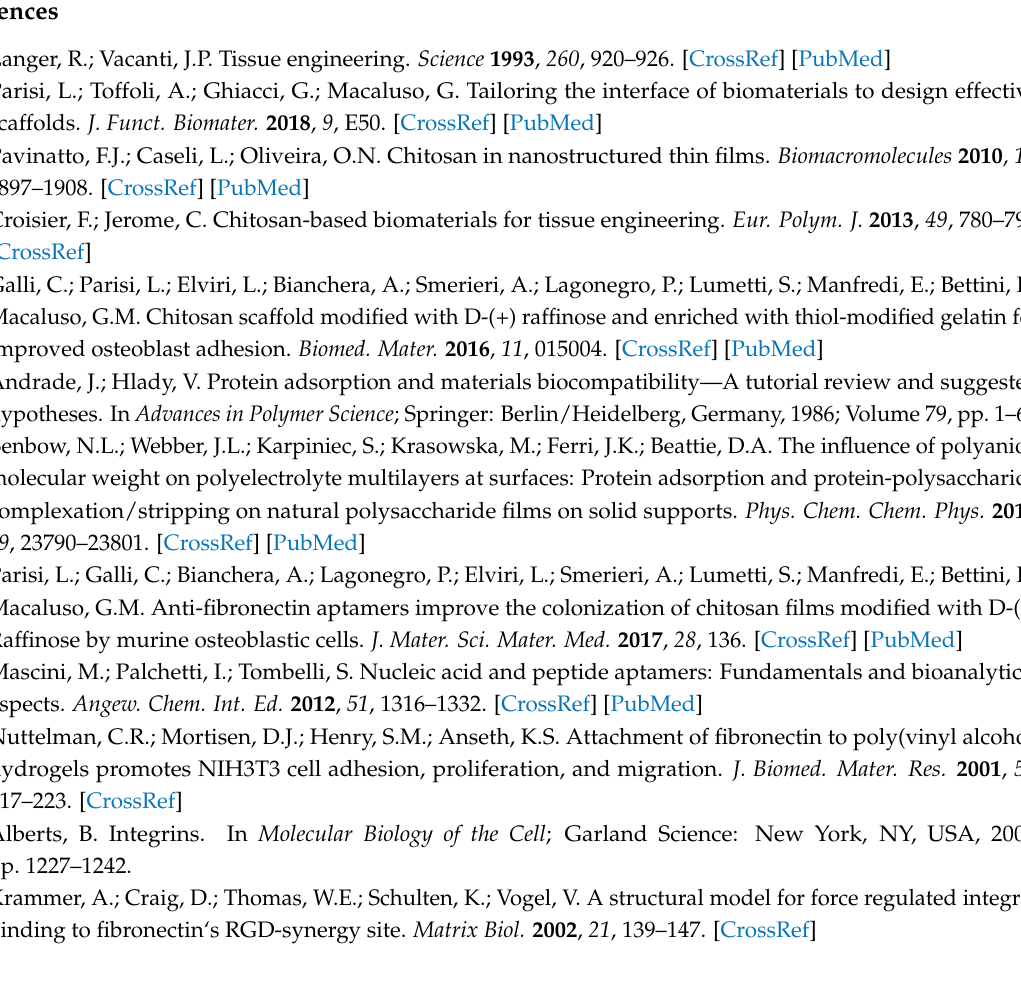
Figure S1: Cytochalasin-D and blebbistatin cytotoxicity on human HeLa cells. Figure S2: HeLa cells spreading on CH and on